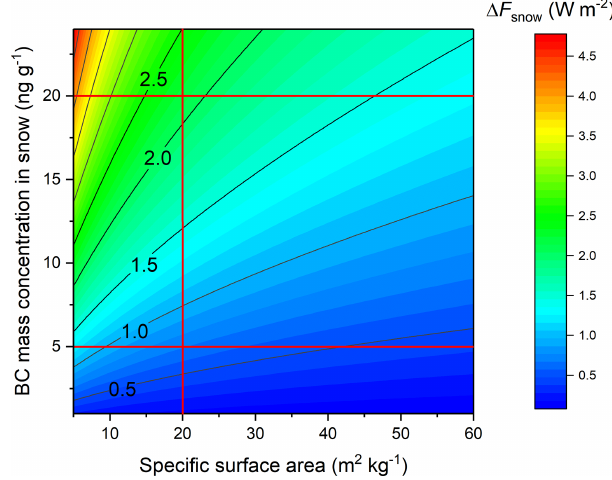
Figure 5. Solar surface radiative forcing of BC impurities in snow (cid:49)F snow calculated for different SSA values and BC particle mass concentrations. The atmospheric conditions correspond to the ACLOUD case with a fixed SZA of 60 ◦ . Horizontal red lines indi- cate typical Arctic conditions with rather clean and more polluted snow; the vertical line represents the most typical